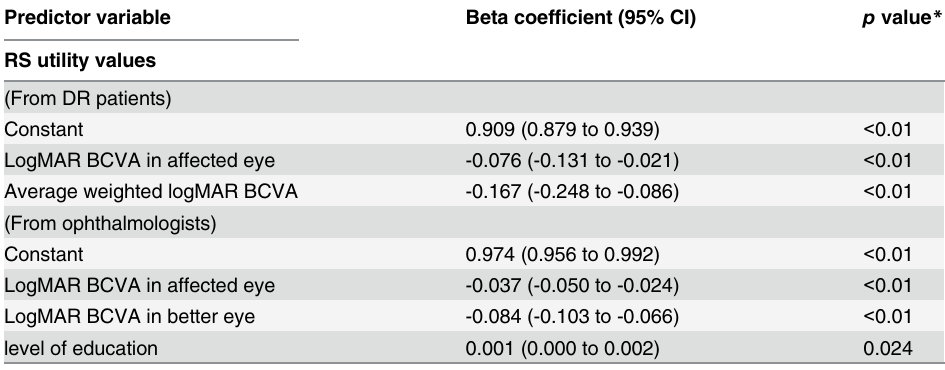
RS, rating scale; CI, con fi dence interval; BCVA, best-corrected visual acuity; DR, diabetic retinopathy.